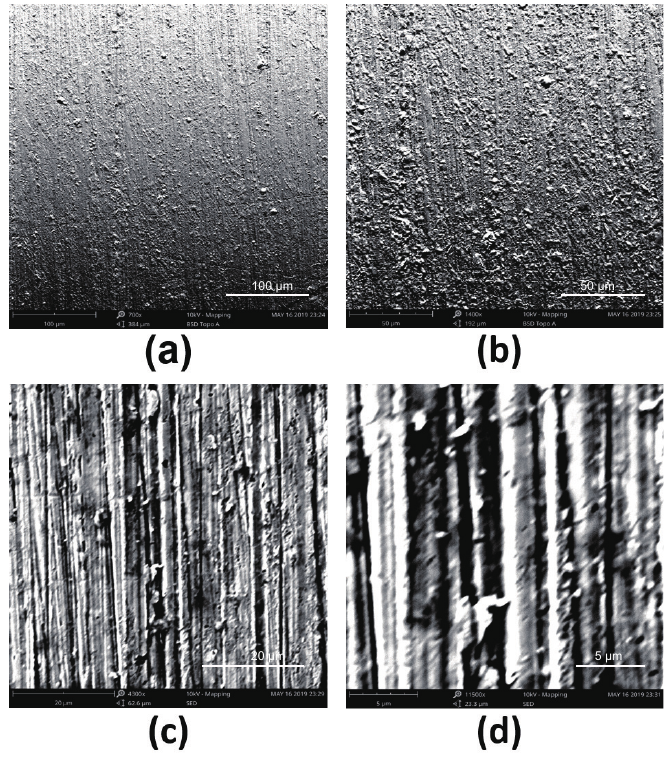
Figure 7. SEM images of brass sample I under various magnifications: ( a ) 700 × , ( b ) 1400 × , ( c ) 4300 × , ( d ) 11,500 × .